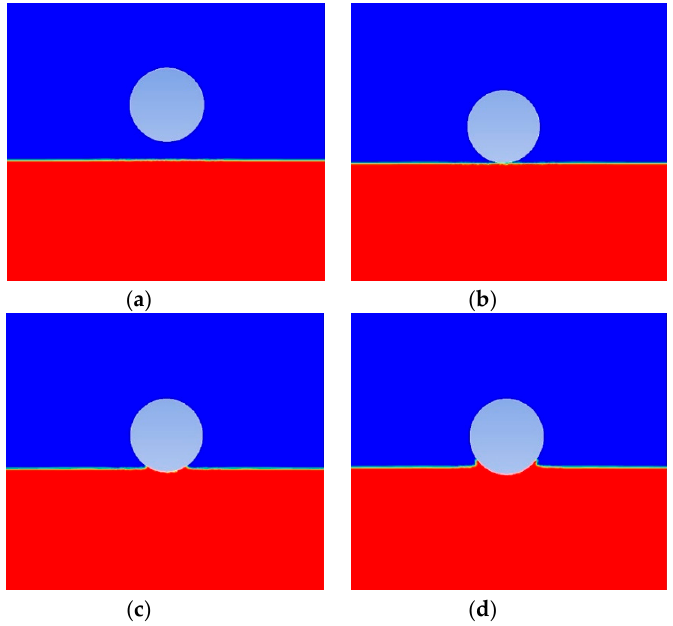
Figure 7. Snapshots of moving cylinder interaction with a free surface flow ( a ) t = 0.0 s, ( b ) t = 0.25 s, ( c ) t = 0.375 s, ( d ) t = 0.435 s.